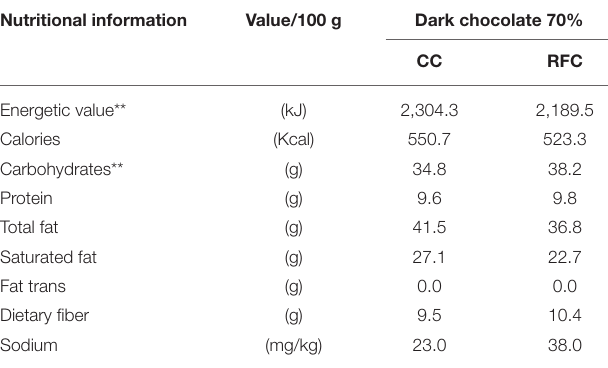
TABLE 6 | Comparison of the nutritional profile of control chocolate (CC) with reduced fat chocolate (RFC).